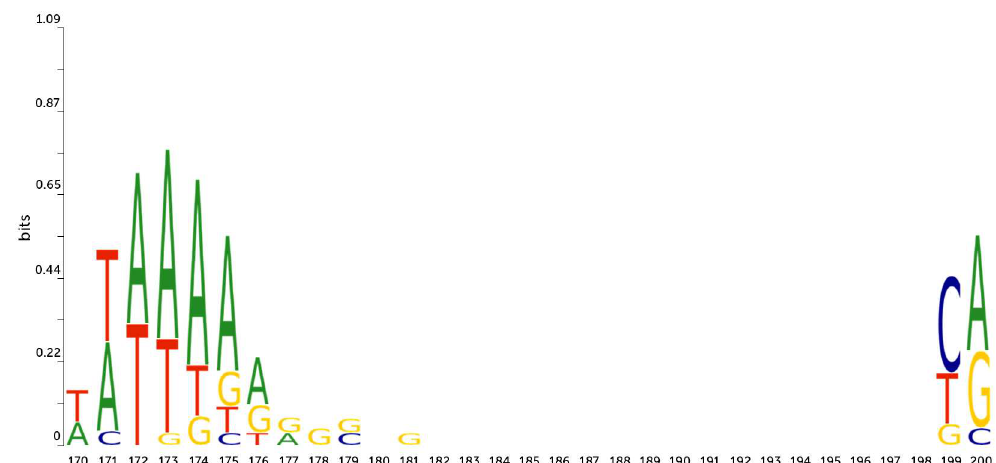
Fig 4. Sequence logo for human TATA promoter sequences in the TATA-box region and TSS region. X- axis is a positionin promotersequence,Y-axis is informationalcontent in bits.